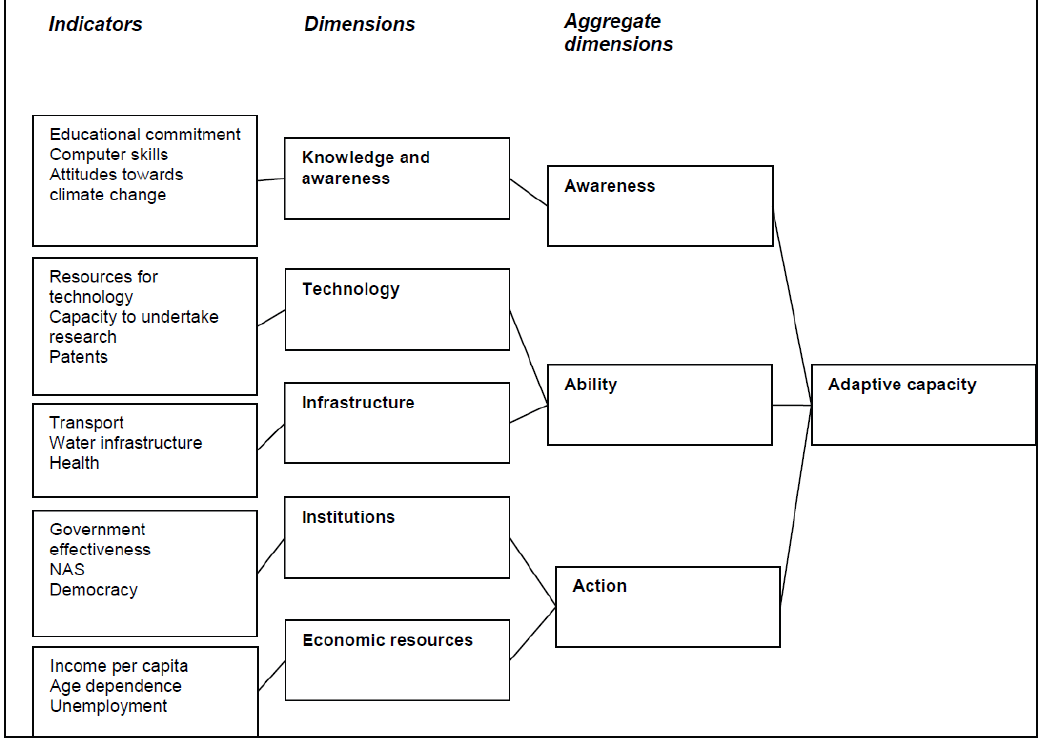
Figure 1. Composition of the adaptive capacity developed by ESPON ( © ESPON